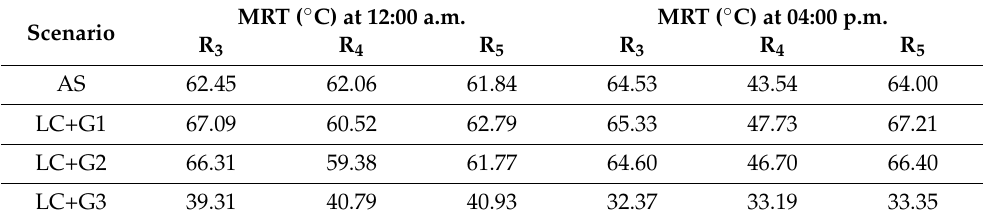
Table 6. MRT values at 12:00 a.m. and 04:00 p.m.